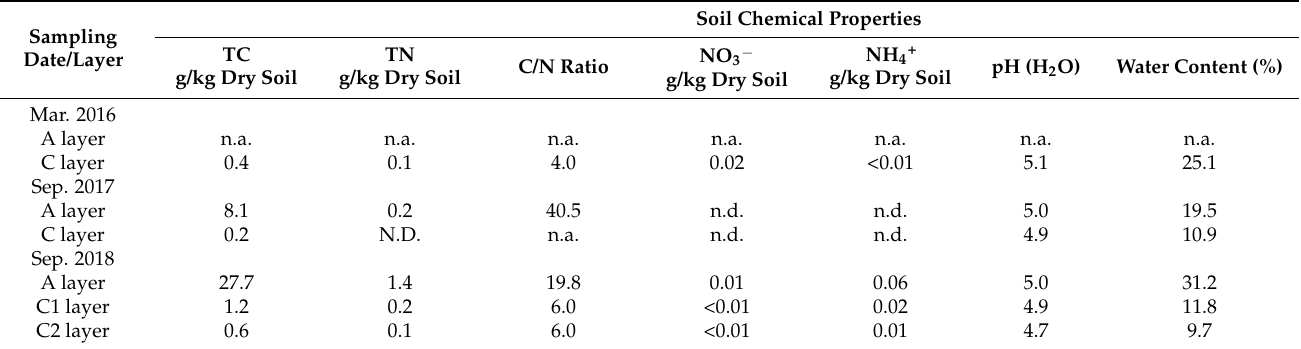
Table 1. Soil chemical properties of soil and volcanic deposit layer on site